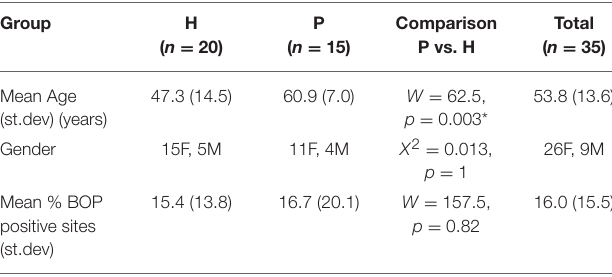
TABLE 1 | Clinical and demographic characteristics.